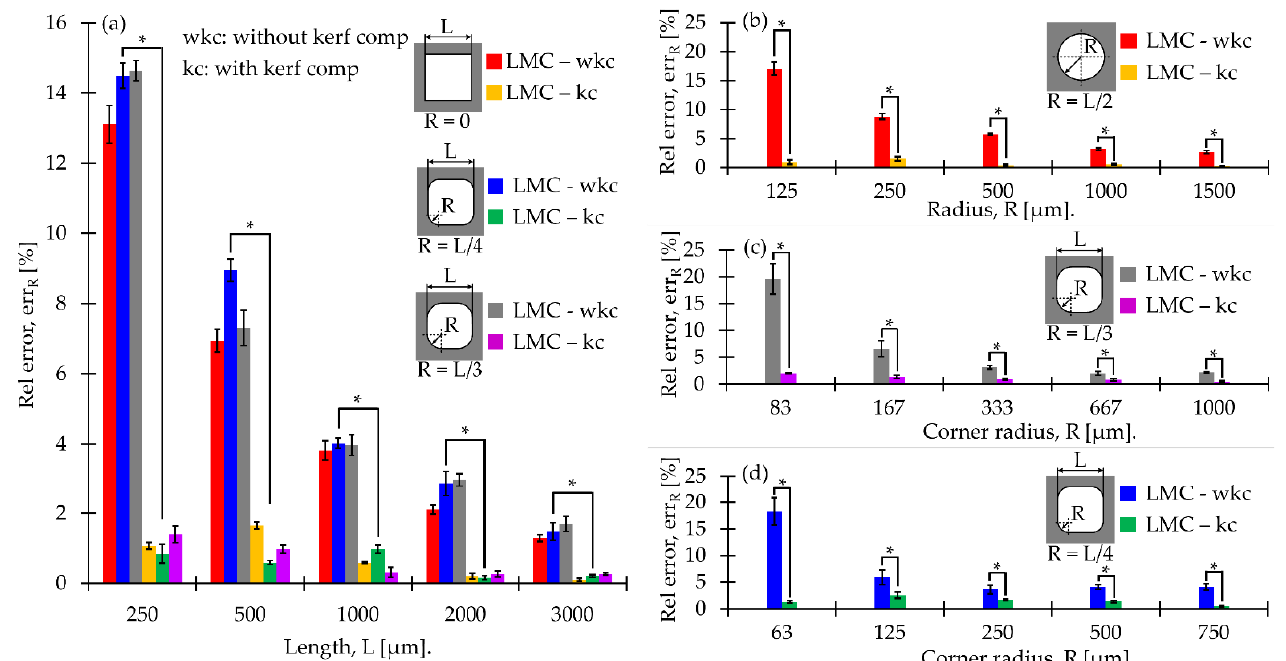
Figure 4. Relative error results from measured: ( a ) length (L) in pores with R = 0, L/4, L/3 and corner radius © in pores with ( b ) R = L/4, ( c ) R = L/3, and ( d ) R = L/2. Note: (wkc: without kerf compensation, kc: with kerf compensation, * p value ≤ 0.0001).